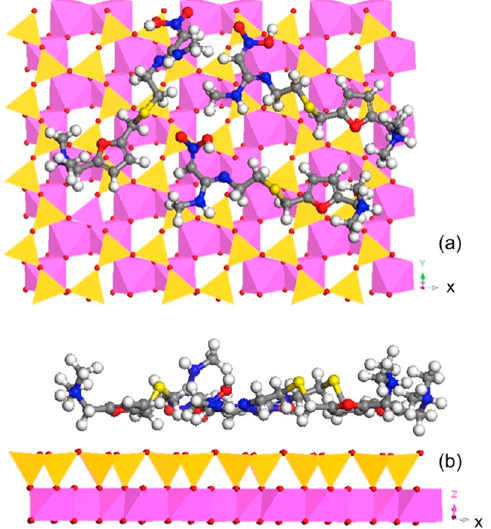
Figure 5. Molecular dynamic simulation showing the monolayer surface configuration of sorbed RT on Kao along ( a ) [001] and ( b ) [010] directions.